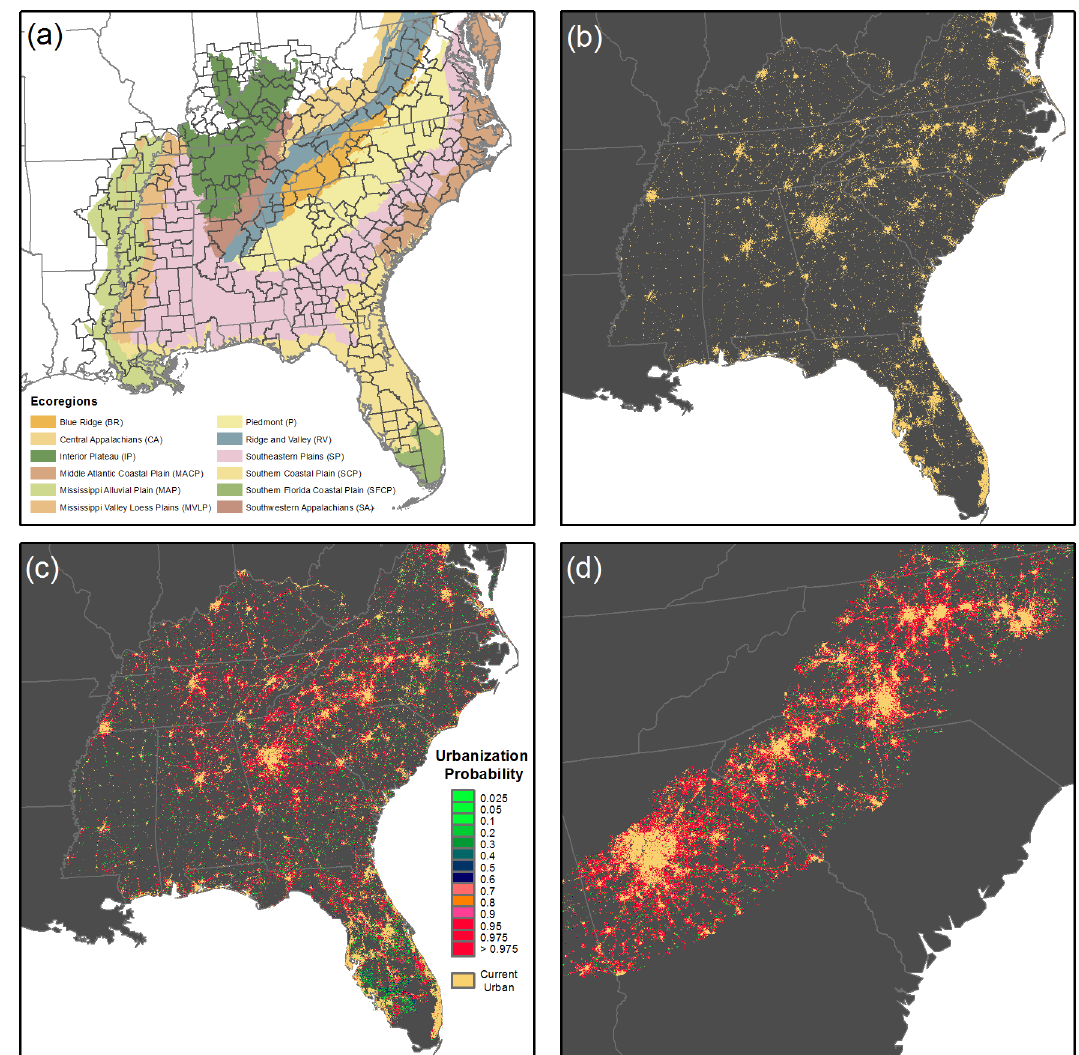
Figure 1. Business-as-usual urbanization scenario for the Southeast US. The Southeast US region used in this study. (a) EPA Level III ecoregions and initial urban extent. The 309 sub-regions (CSAs and rural county groups) used to calibrate the SLEUTH model are outlined in black. Red areas are urban extent as classified by our hybrid NLCD-TIGER dataset method (see File S1). (b) Initial urban land cover in 2009. (c) projected urban land cover in 2060. (d) projected urban land cover in Piedmont ecoregion, showing connected urban